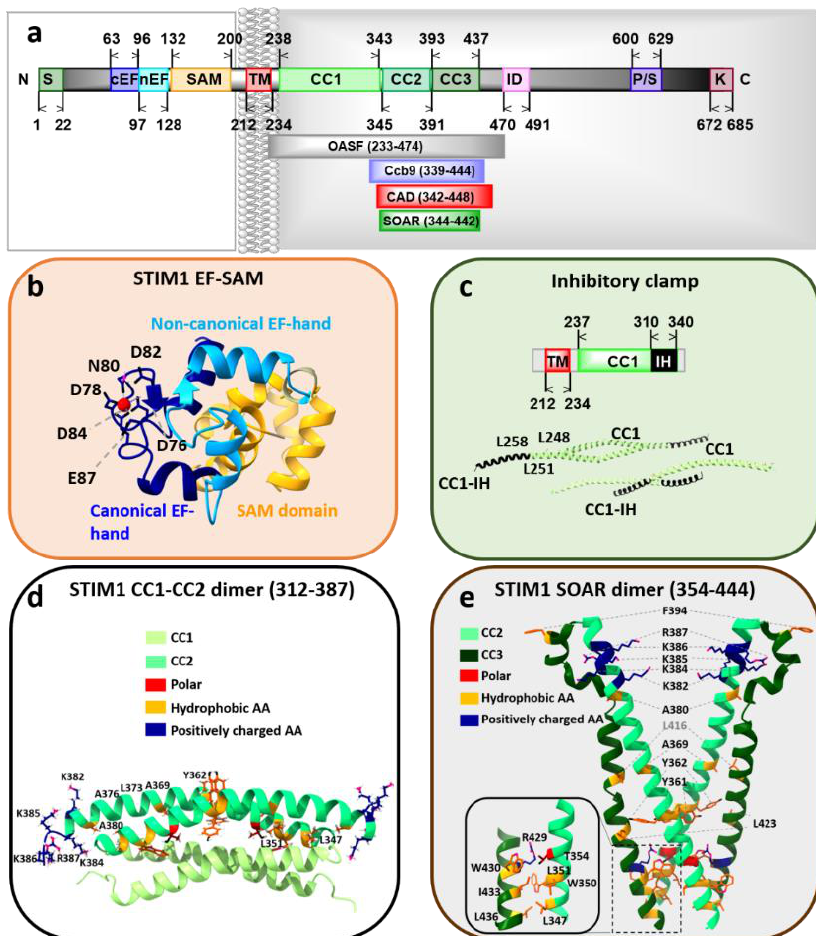
Figure 2. The structural features of Stromal interaction molecule 1 (STIM1). ( a ) Scheme displays the full-length human STIM1 with highlighted regions critical for the regulation of the STIM1 / Orai1 signaling cascade. Important fragments, such as OASF, Ccb9, CAD, and SOAR are further shown as insets. ( b ) The high-resolution EF-SAM domain structure of human STIM1 loaded with a Ca 2 + ion (red sphere) is displayed. The residues with proposed Ca 2 + -binding ability are highlighted. ( c ) The crystal structure of STIM1 CC1-inhibitory helix domain with the critical residues maintaining the STIM1 quiescent state are presented. ( d ) The NMR structure of a STIM1 CC1 α 3-CC2 dimer with the two monomers coupled in an antiparallel manner. Each monomer is bent with a sharp kink between the two coiled-coil domains. ( e ) The crystallographic structure of the STIM1 SOAR dimer, forming a V-shape. A single monomer comprises CC2 and CC3 domains and resembles the capital letter, “R.” Residues that represent potential interaction sites within the dimer and those mediating coupling to Orai1 are highlighted. Left inset: Magnified view of amino acids involved in dimer interactions between the N-terminal portion of the first SOAR monomer and the C-terminal portion of the second SOAR